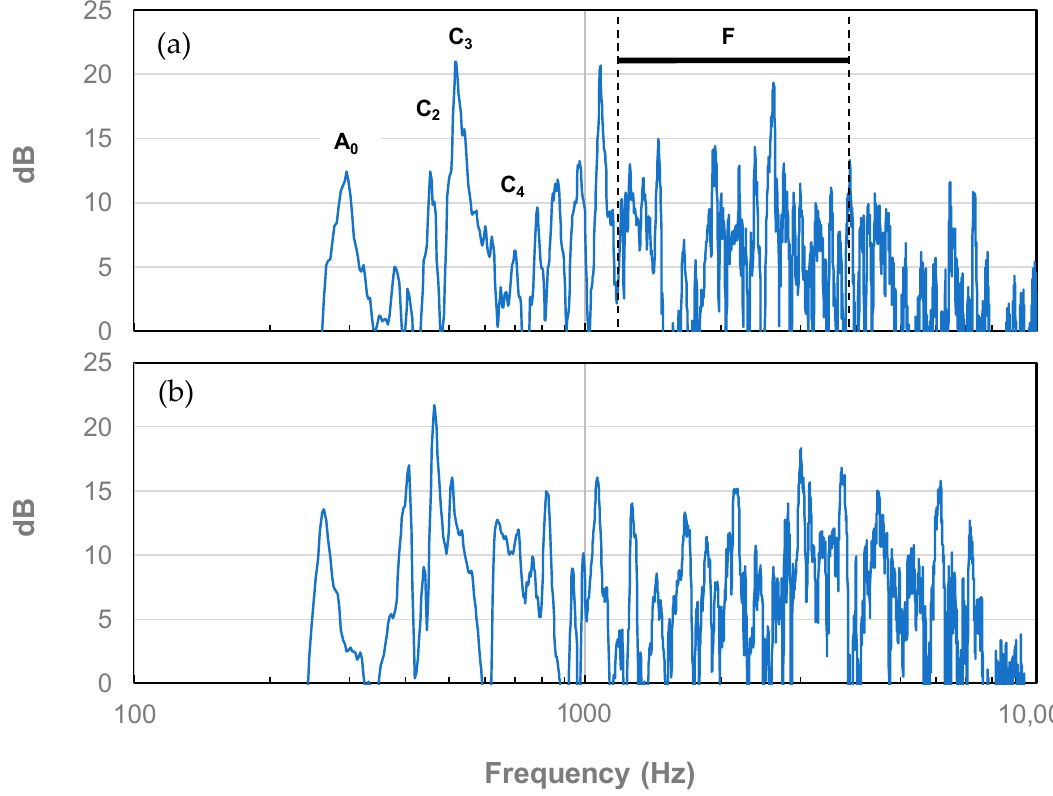
Figure 1. Mobility plots of the “Plowden” del Gesù (1735) ( a ) and a good commercial violin ( b ).